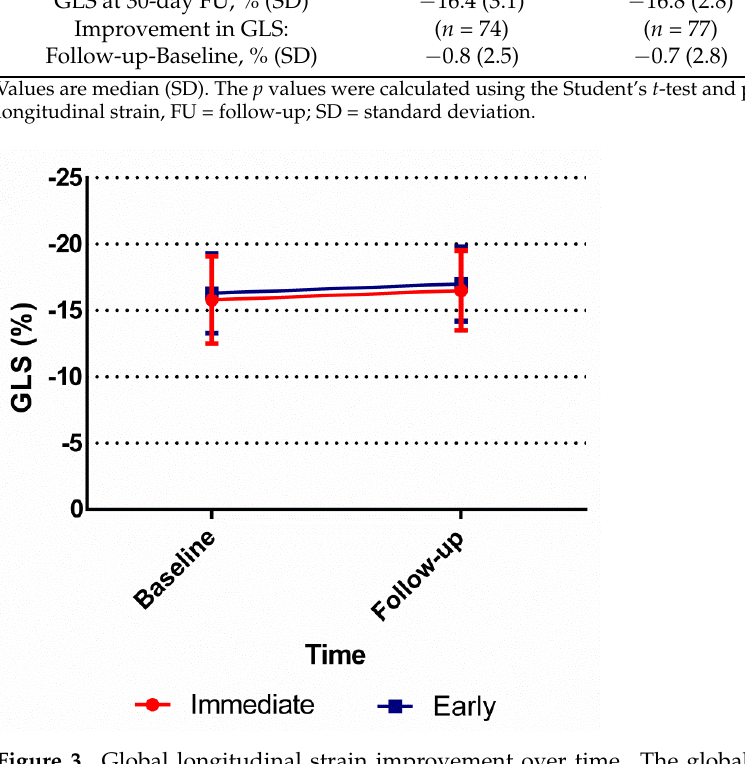
Figure 3. Global longitudinal strain improvement over time. The global longitudinal strain of both the immediate invasive strategy and early invasive strategy groups at baseline and at 30-day follow-up. GLS = global longitudinal strain.